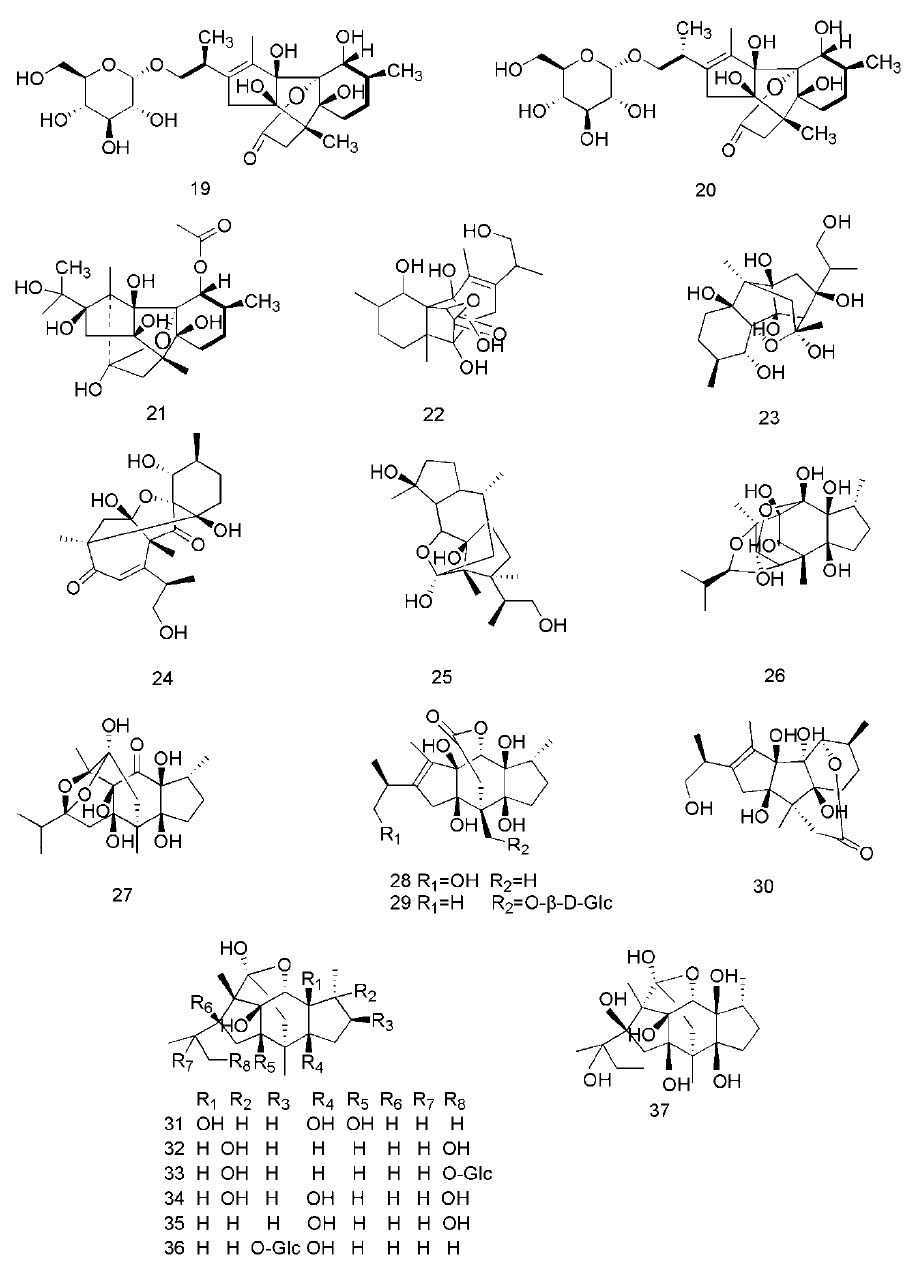
Figure 3. Chemical structures of the diterpenoids in C. cassia .